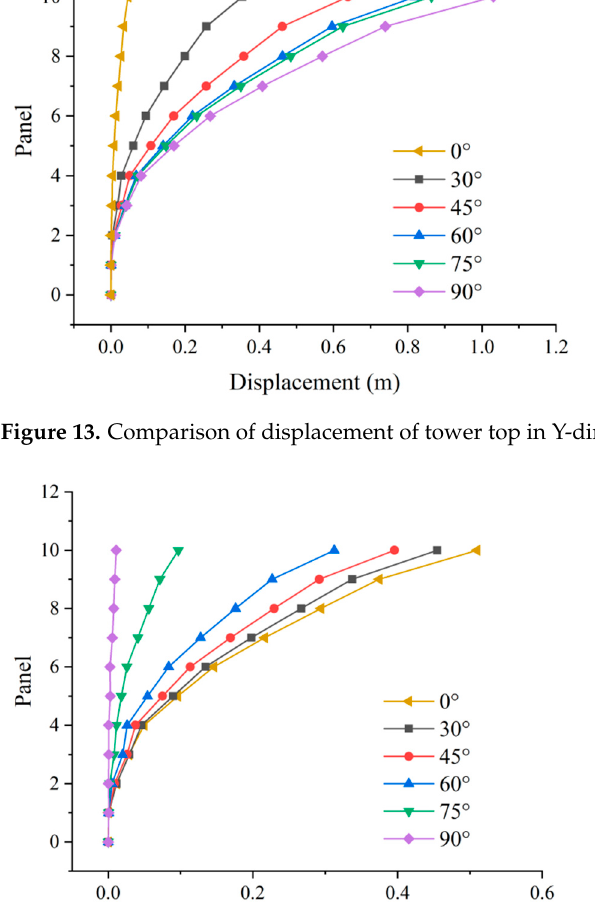
Figure 14. Comparison of displacement of tower top in X-direction.